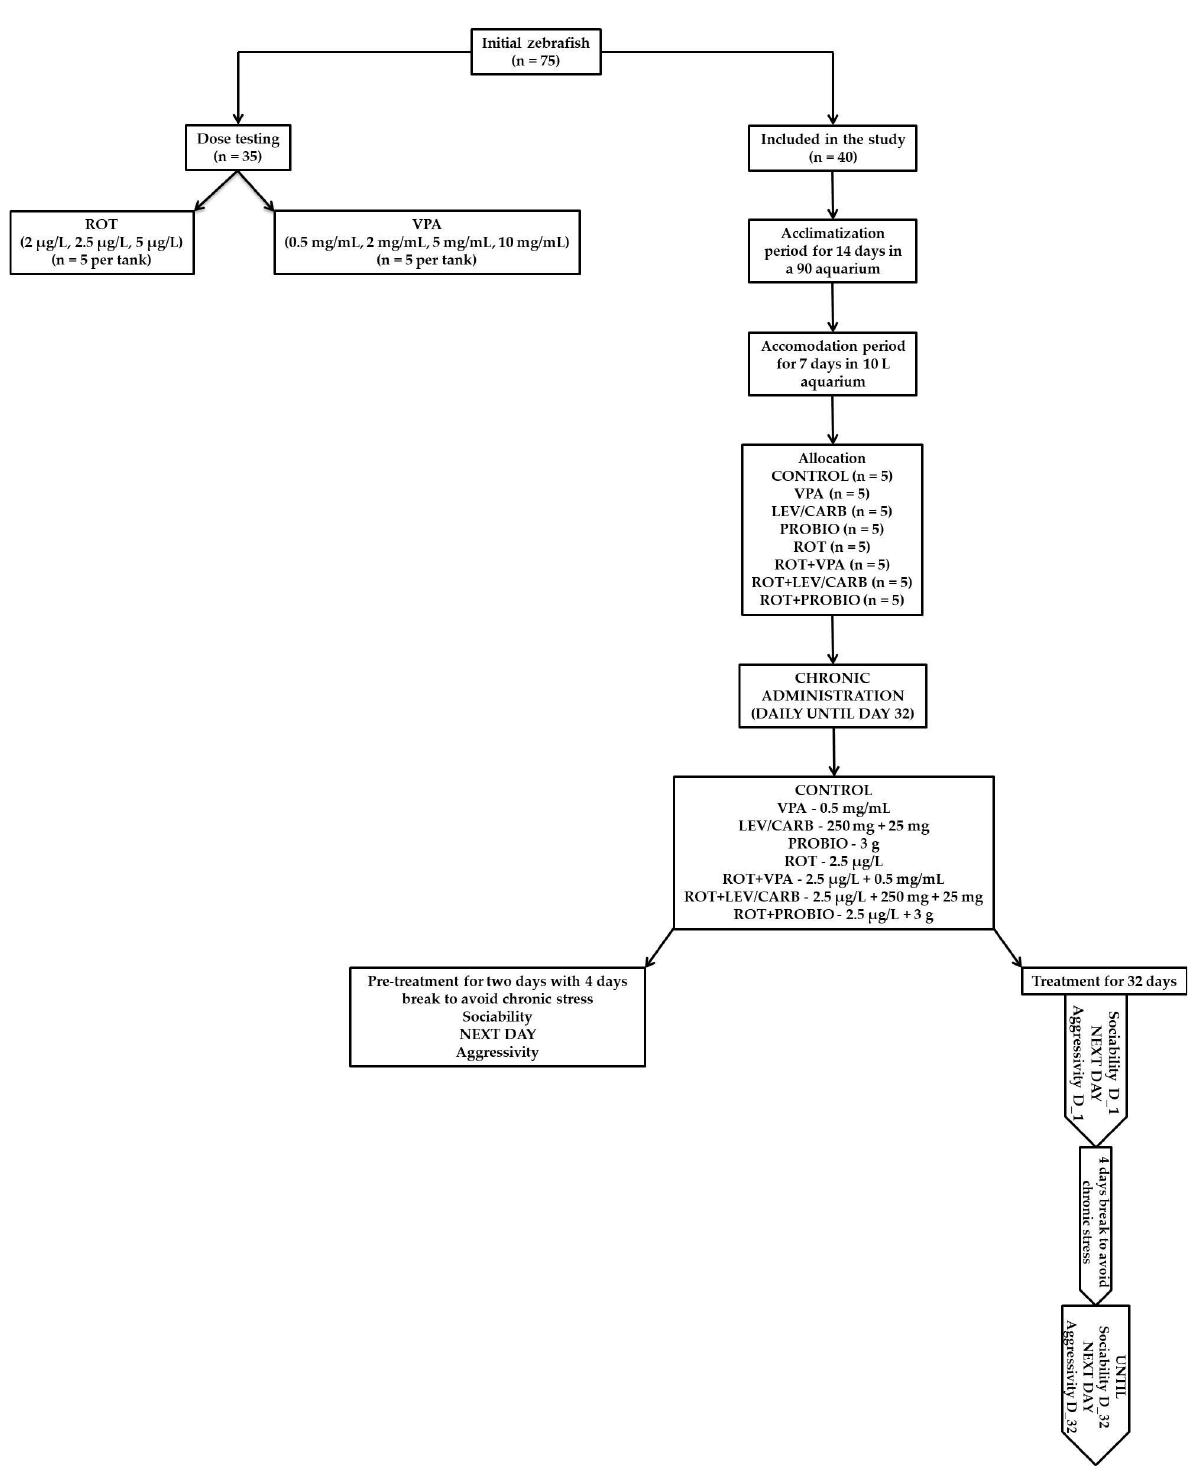
Figure 1. A CONSORT-style flow diagram of the study design.